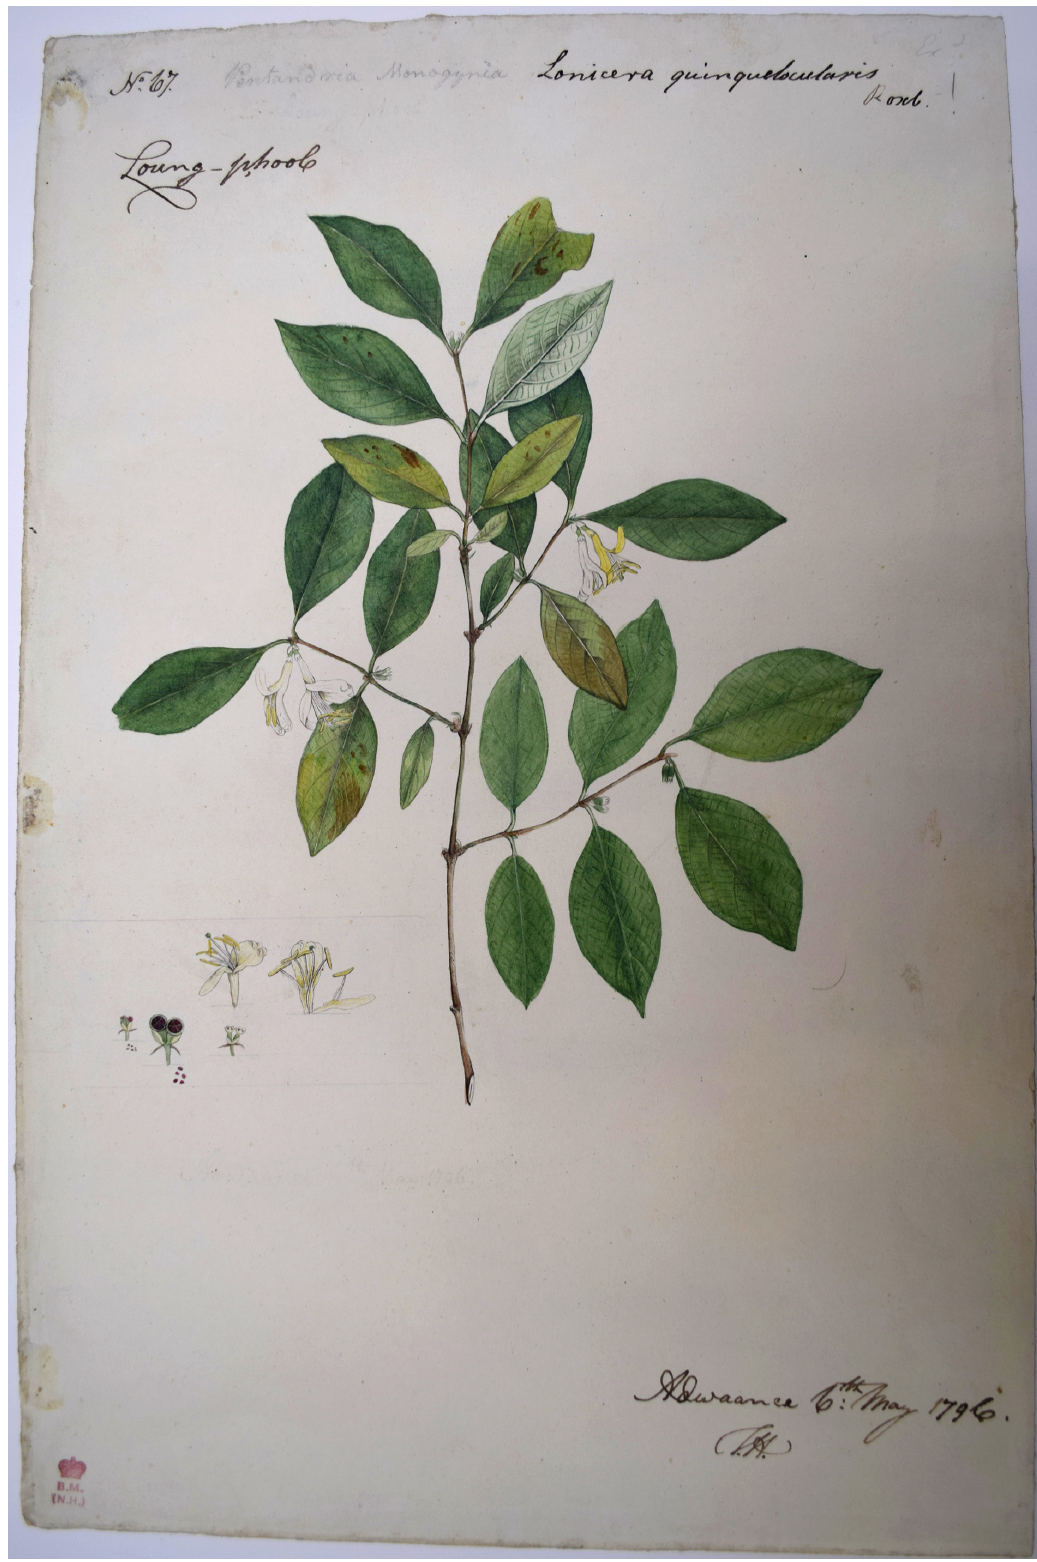
Fig. 3. Lectotype of Lonicera quiquelocularis Hardw., Hardwicke Drawing no. 67 from the collection of the Botany Library, Natural History Museum. © The Natural History Museum,